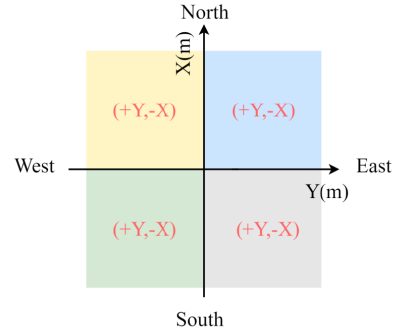
Figure 13. Path planning coordinates. Table 4. Planning end points and actual end points of arrival.